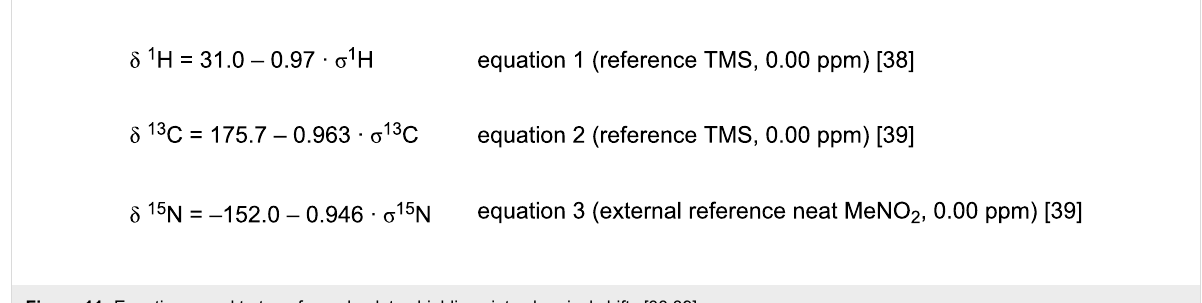
level of –3 dB and relaxation delay of 2 s, WALTZ-16 used for broadband proton decoupling; the FIDS were multiplied by an exponential weighting (lb = 1 Hz) before Fourier transforma- tion. Typical parameters for 19 F NMR spectra were spectral width of 55 kHz, pulse width of 13.75 μ s at an attenuation level of –6 dB and relaxation delay of 1 s. WALTZ-16 was used for broadband proton decoupling 19 F{ 1 H}, the FIDS were multi- plied by an exponential weighting (lb = 1 Hz) before Fourier transformation. Homonuclear 19 F − 19 F experiment does not require any modification of the standard gs-COSY pulse sequences; selected parameters for 19 F COSY spectra were: spectral width of 55 KHz, TD1 = 512 for F 1 domain, spectral width of 55 KHz, TD1 = 1024 for F 2 domain, number of scans 4, dummy scans DS = 2 and relaxation delay of 1